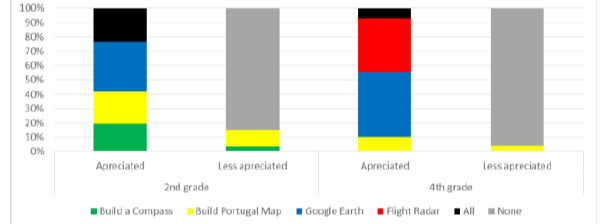
Figure 5: Most and least appreciated activities by second and fourth grade